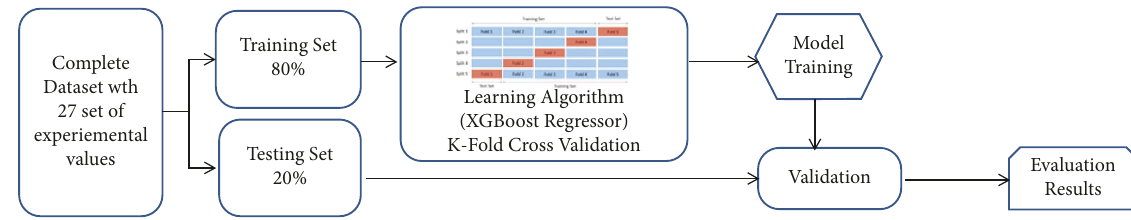
Figure 4: Workflow implemented for ML model